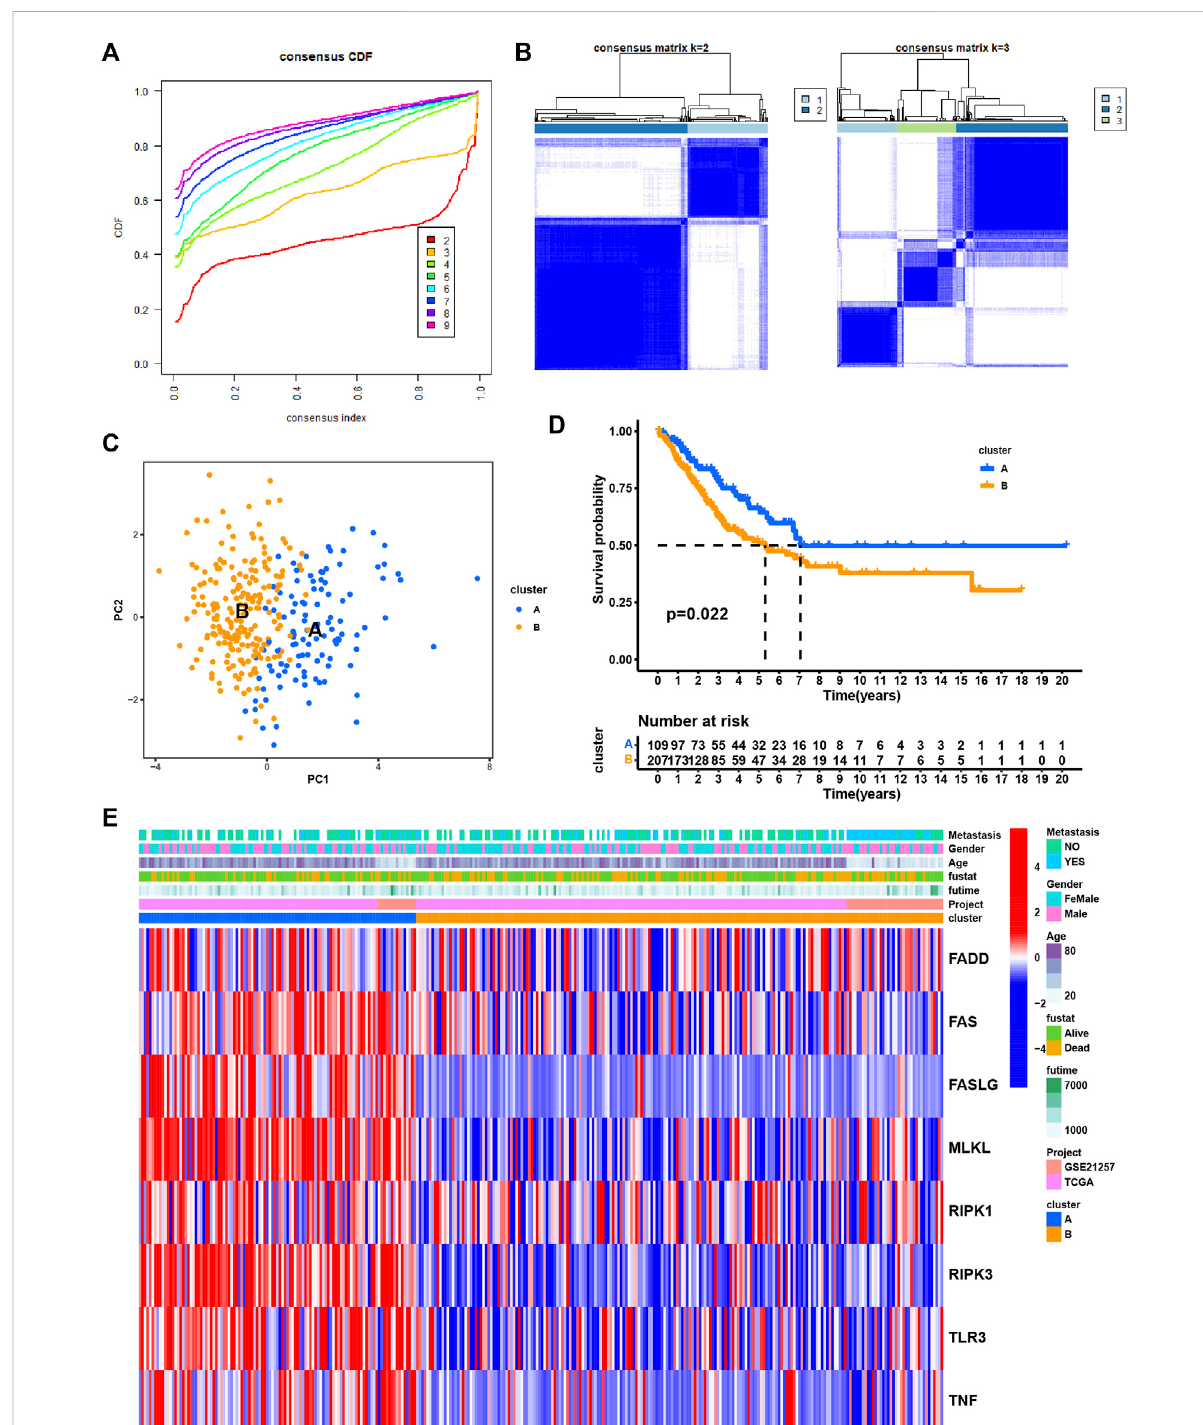
FIGURE 3 Identi fi cation of subtypes based on the eight necroptosis genes. (A) Cumulative distribution function (CDF) curve under different cluster number(K) (B) Consensusmatrixheatmapde fi ningdifferentclusters(k=2and3)andtheircorrelationarea. (C) PCAplotdisplayingthedistributionof cluster A and (B,D) Kaplan-Meier survival analysis of SARC patients in two clusters. (E) . Distributions of clinical features and expression levels of necroptosis genes between two